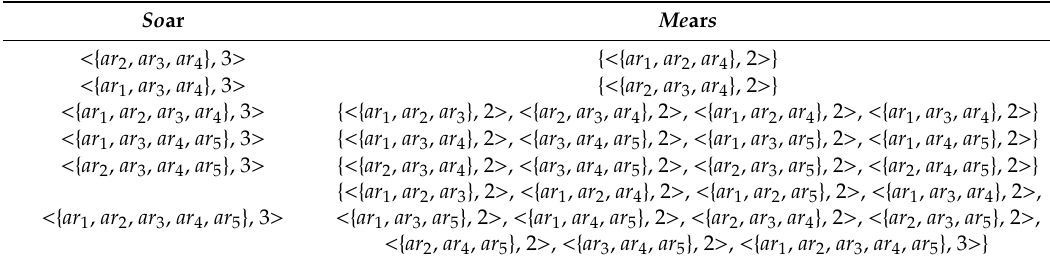
Table 16. Di ff erent sets of mears with respect to soars .